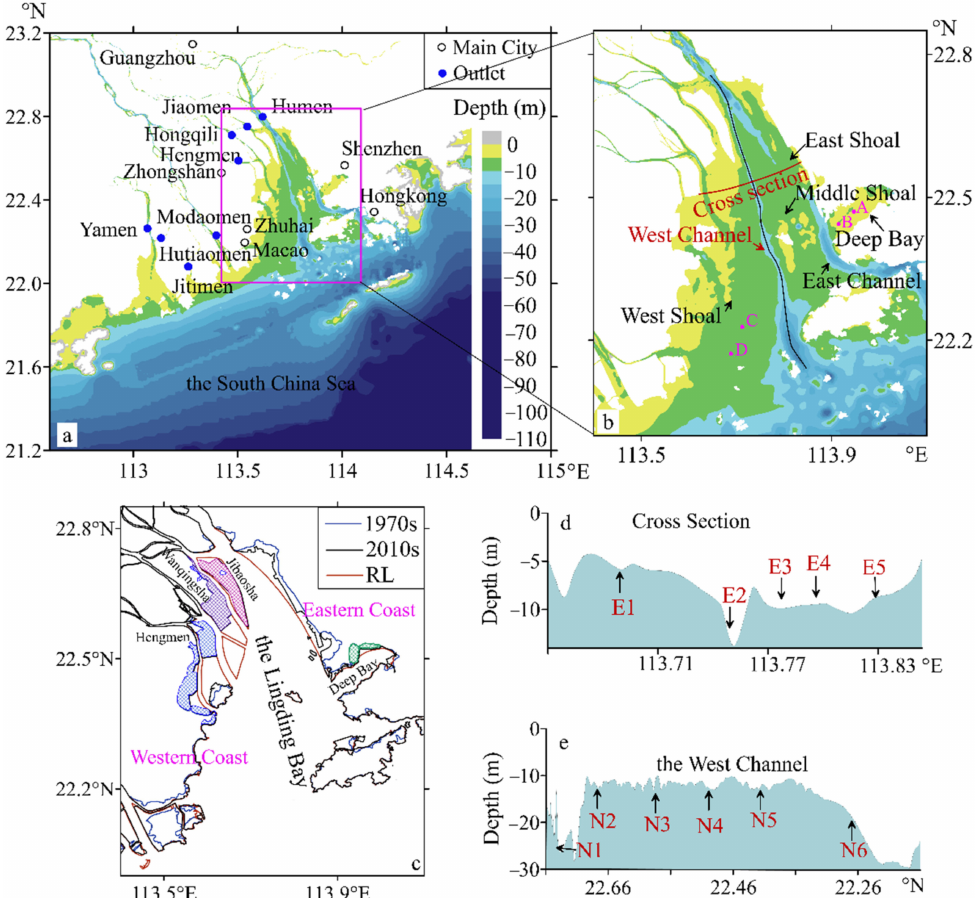
Figure 1. ( a , b ) Bathymetry of the Pearl River Estuary and the detailed geography of Lingding Bay, ( c ) the main reclamations in Lingding Bay; the solid lines are shorelines in three scenarios (RL: regulation line, specified by the Pearl River Water Resources Commission of the Ministry of Water Resource), ( d , e ) the profiles of the